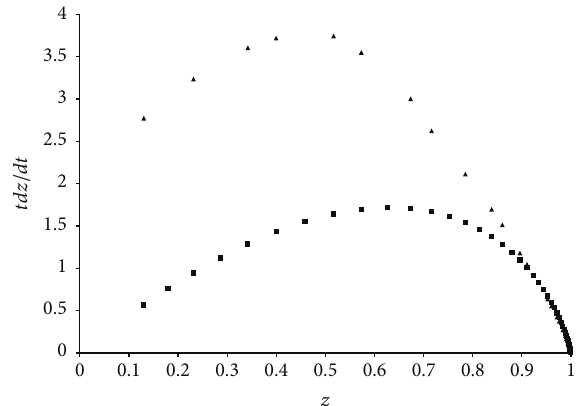
Figure 3: Plot of 𝑡𝑑𝑧(𝑡)/𝑑𝑡 obtained, respectively, as −𝑛( 1 − 𝑧(𝑡)) ln ( 1 − 𝑧(𝑡)) (squares) and with the Taylor formula [34, 35] (triangles) for neat In crystallized at 155 ∘